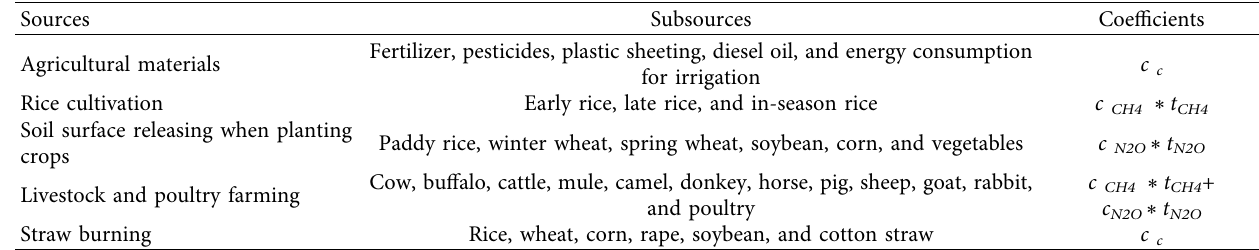
Table 2: Agricultural carbon emission